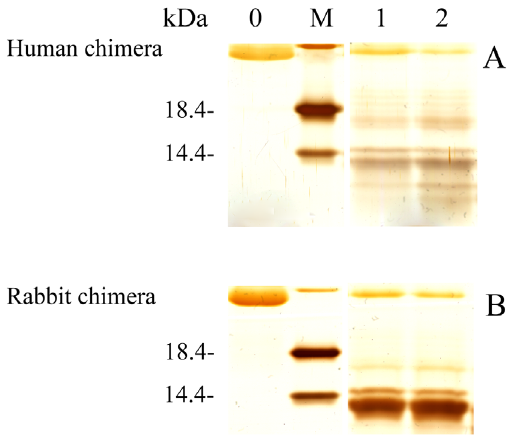
Figure 6. Concentration-dependent proteinase K-digestion assays of human (A) and rabbit (B) chimera PrP fibrils. Samples were treated with PK for 1 h at 37 u C at PK: PrP molar ratios as follows: 1:100 (lane 1) and 1:50 (lane 2). PK concentration: 0.4 m g/ml (lane 1) and 0.8 m g/ml (lane 2). The controls with zero protease in the absence of a crowding agent were loaded in lane 0. Protein molecular weight markers were loaded on lane M: restriction endonuclease Bsp98 I (25.0 kDa), b -lactoglobulin (18.4 kDa), and lysozyme (14.4 kDa). Amy- loid fibrils were produced from human chimera and rabbit chimera in the absence of a crowding agent. Protein fragments were separated by SDS-PAGE and detected by silver staining.